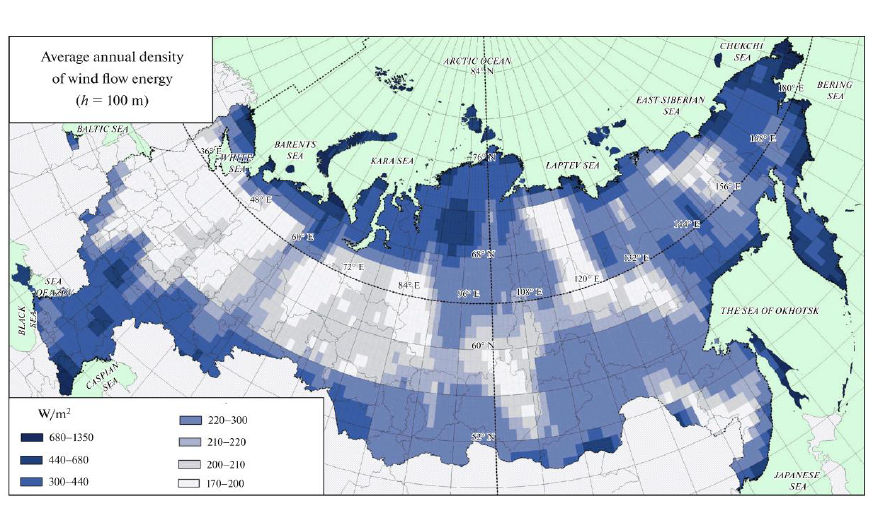
Fig. 1. Average annual energy density of wind flow (W/m 2 )